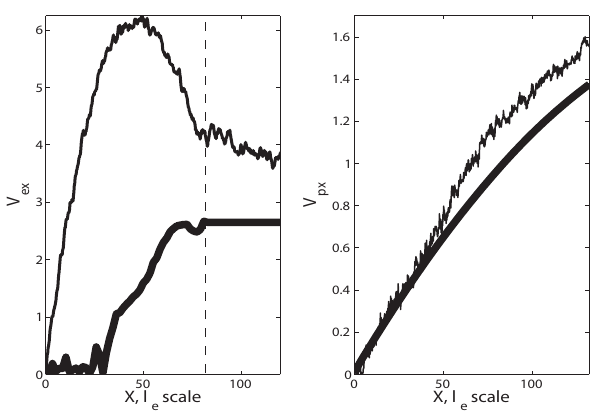
Fig. 4. Electron velocities V ex (x, 0 ) (left panel) and proton veloci- ties V px (x, 0 ) (right panel): analytical model (thick) and PIC sim- ulation (thin). Vertical dished line on the left panel marks the EDR boundary. Strictly speaking, quantity V ex is undefined inside the EDR, 0 <x< 80.